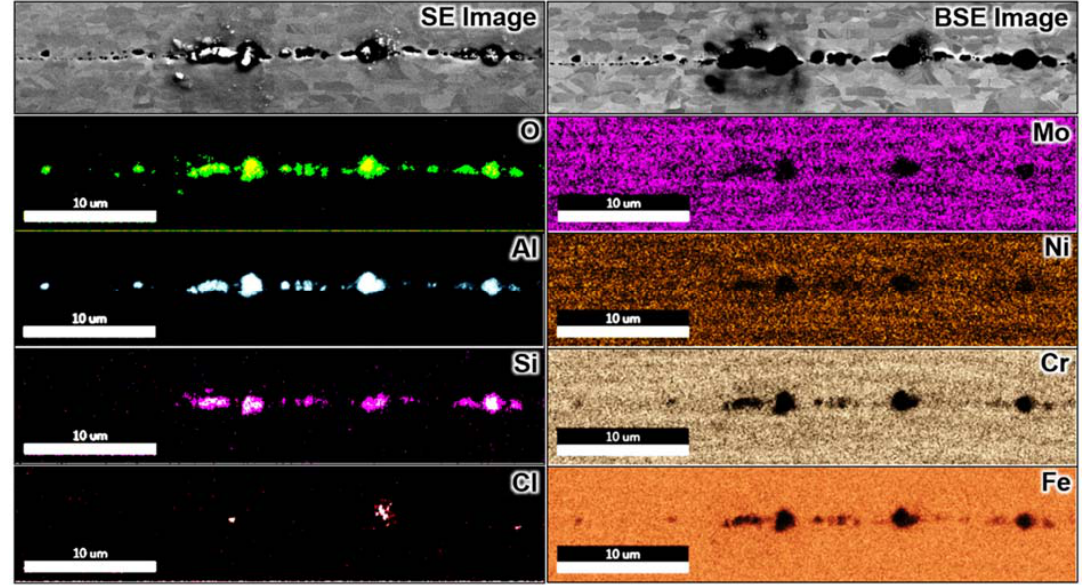
Figure 8. SEM and EDX analysis over a selectively corroded region after potentiostatic polarisation in 0.01 M NaCl at 900 mV vs. Ag/AgCl at pH 3 and 60 °C. The images show that selective corrosion of the ferrite phase proceeded by the initiation of individual corrosion pits along the rolling direction (horizontal axis of the images). The scale bar in the chemical maps also applies to the SEM images.